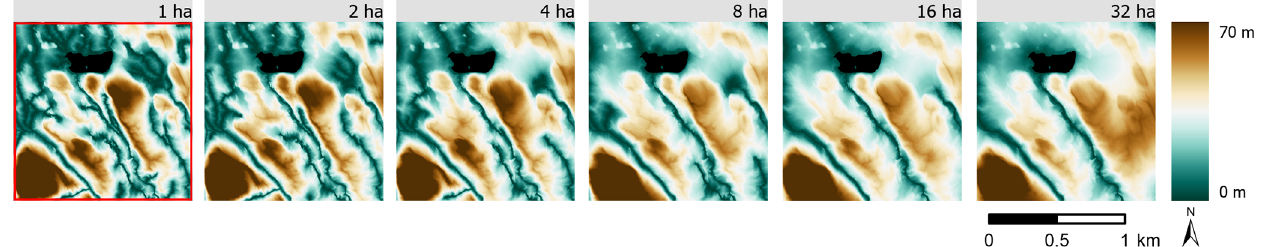
Figure 6. Maps of DTW at 1m resolution with stream initiation thresholds from 1 to